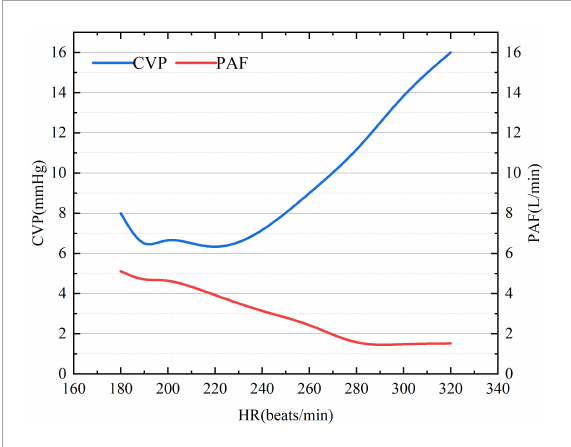
FIGURE1 The association of ventricular rate with CVP and PAF under VT after CF-LVAD implantation. CVP, central venous pressure (right atrial pressure here); PAF, pulmonary artery flow.